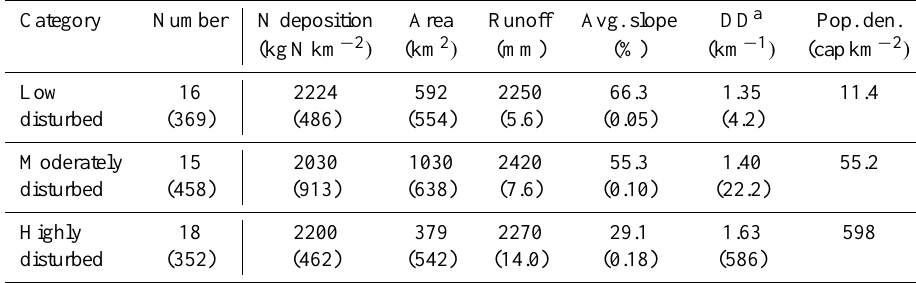
Table 2. Watershed environmental settings of the three categories of watersheds.